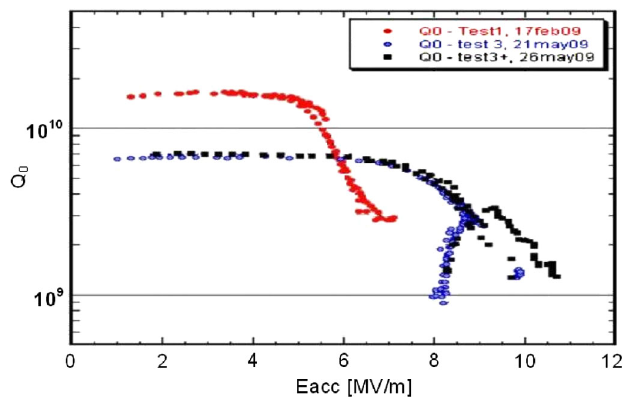
to room temperature then cooldown (black square).